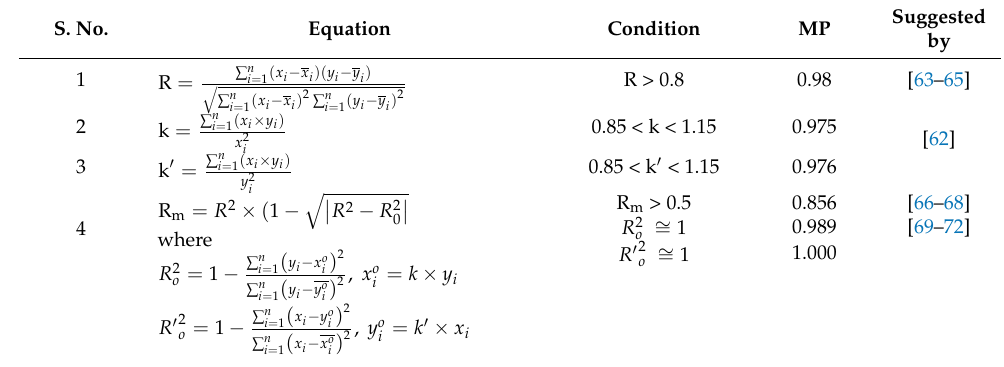
Table 6. External validation of data.